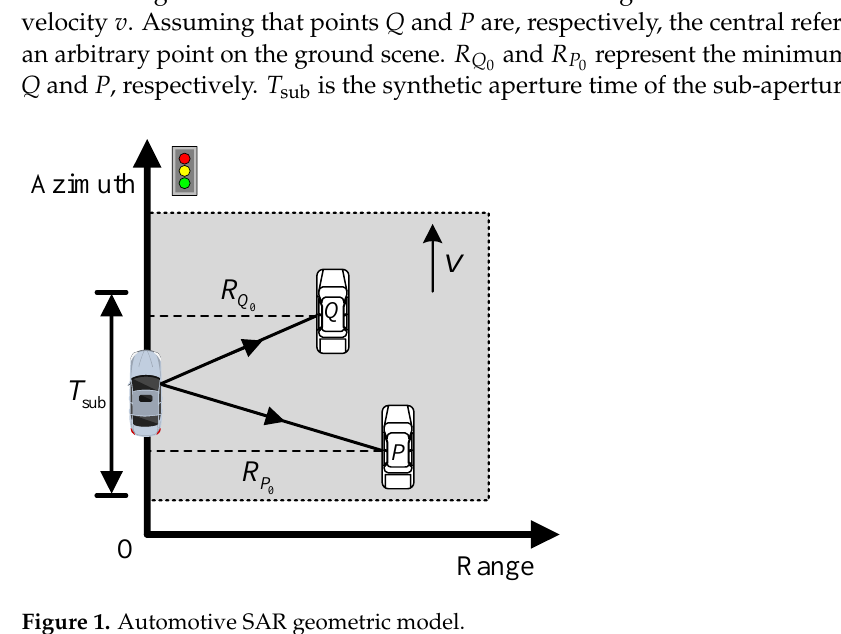
Figure 1. Automotive SAR geometric model.